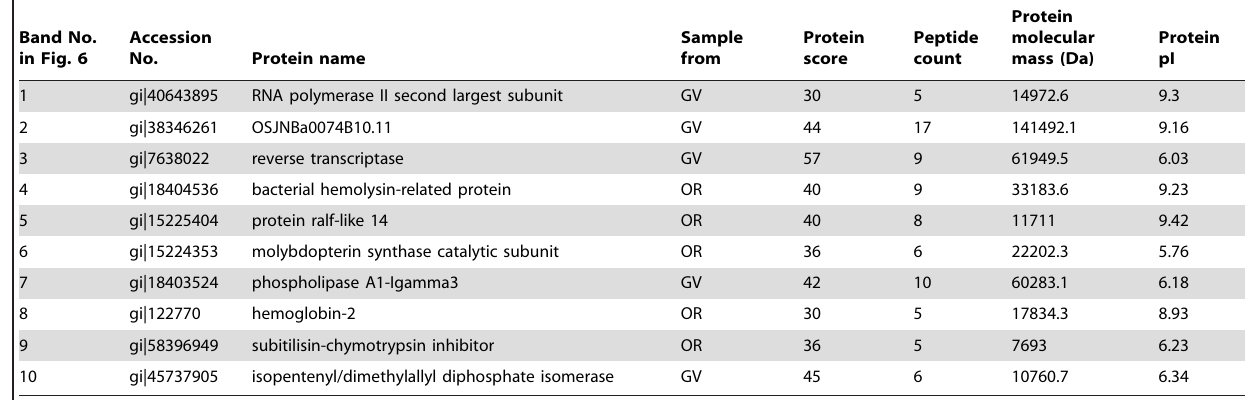
Table 3. Protein list identified by MALDI-TOF/TOF MS.